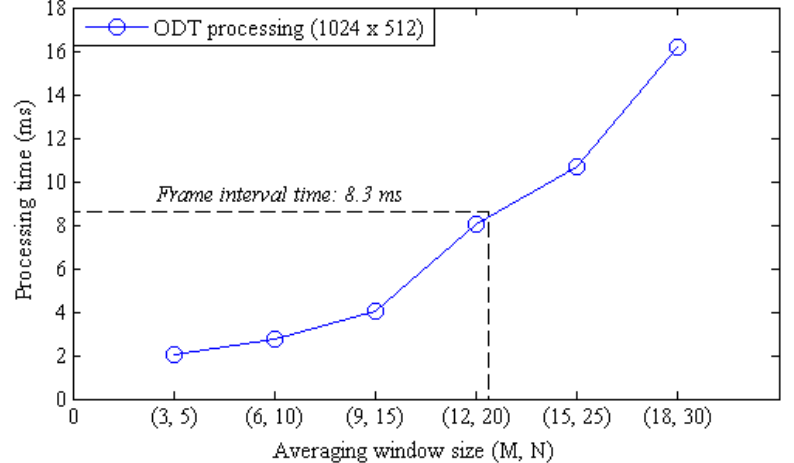
Figure 4. Comparison in ODT processing time between averaging window